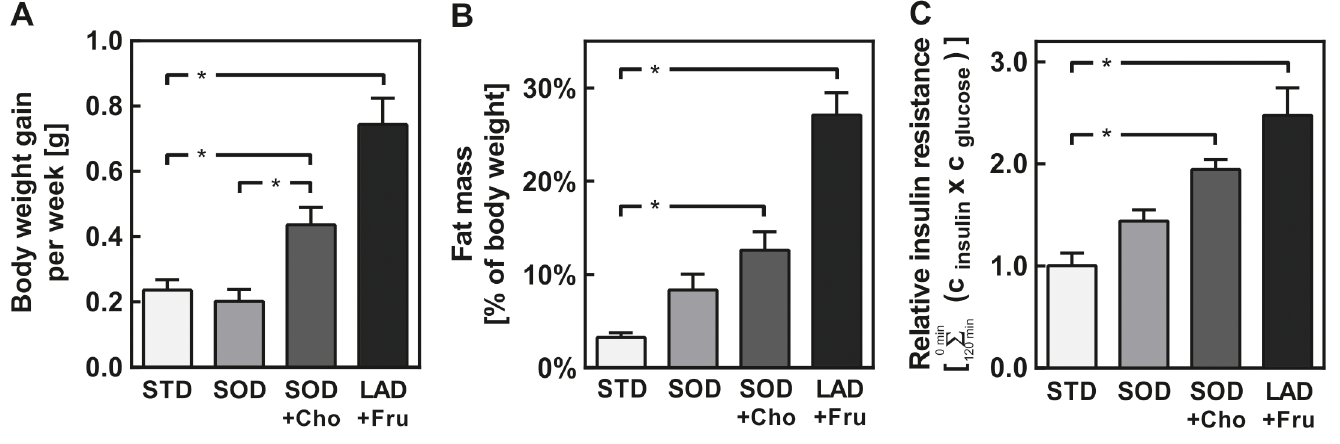
Figure 4. Increased weight gain, fat mass and insulin resistance in mice fed a soybean oil diet + cholesterol or a lard diet + fructose. Mice received diets as described in Figure 1. (A) Average body weight gain per week over 19 wks. (B) Fat mass in wk 20. (C) Relative insulin resistance was calculated by the sum of the products of insulin concentration × glucose concentration during oral glucose tolerance test. Values represent mean ± standard error of the mean of 5 mice per group. Statistics: One-way analysis of variance with Dunnett’s post hoc test or, where appropriate, Tukey’s post hoc test for multiple comparisons, *p